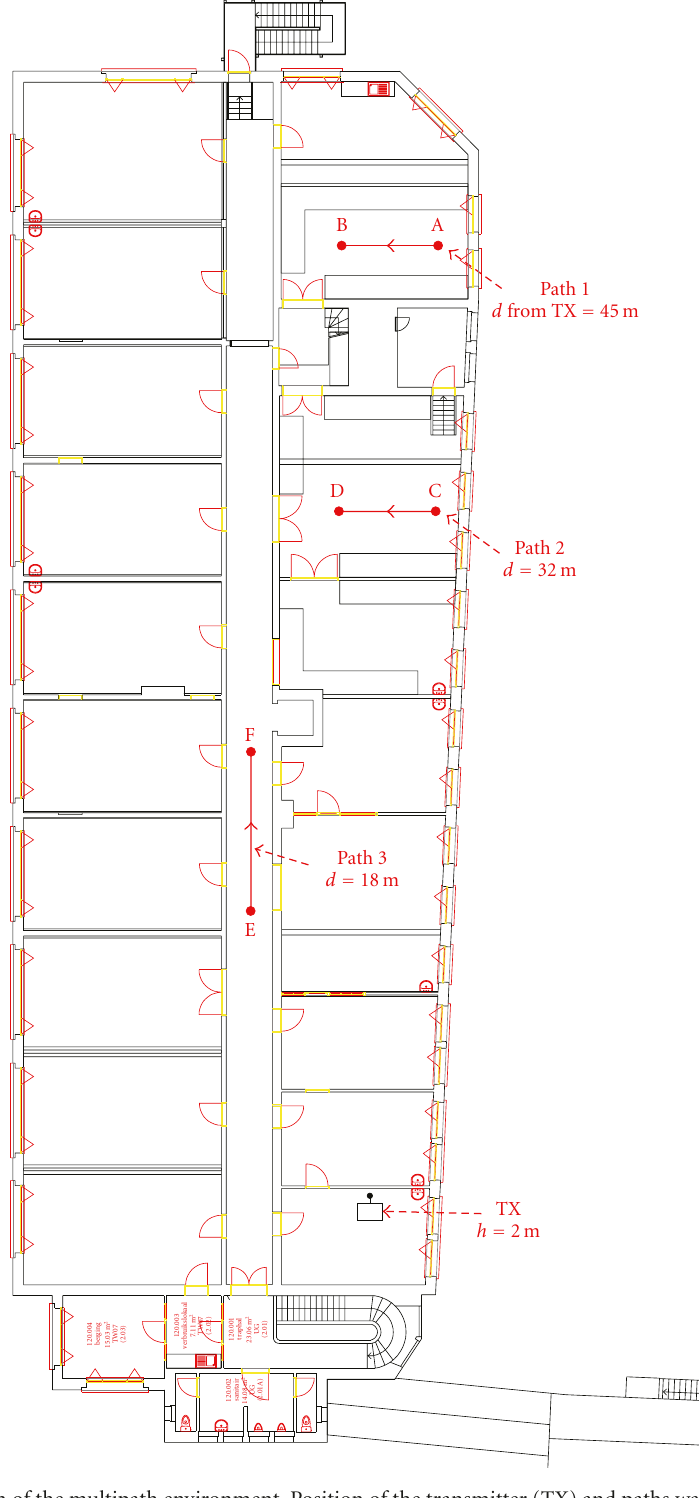
Figure 4: Floor plan of the multipath environment. Position of the transmitter (TX) and paths walked by the receiving